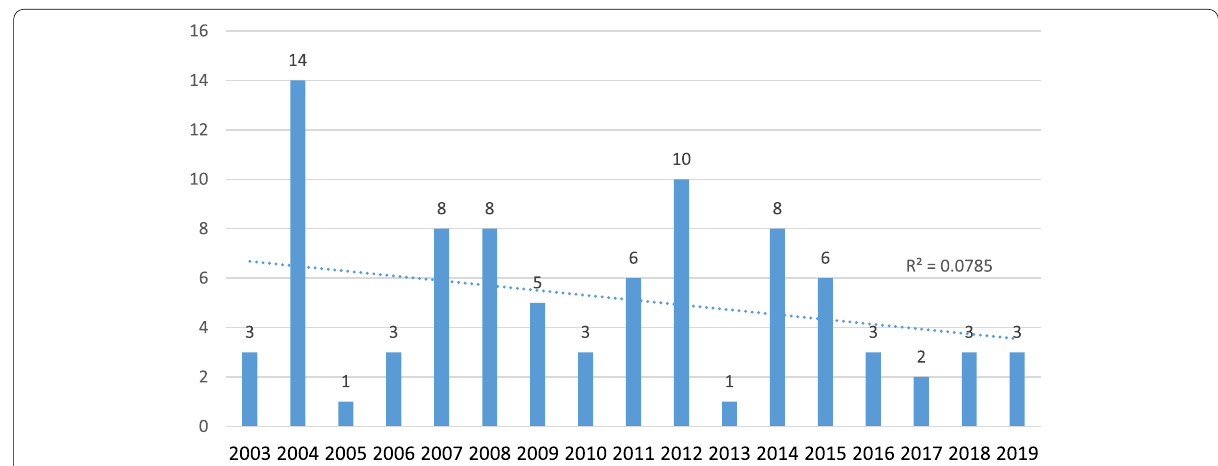
Fig. 1 Distribution of cases by